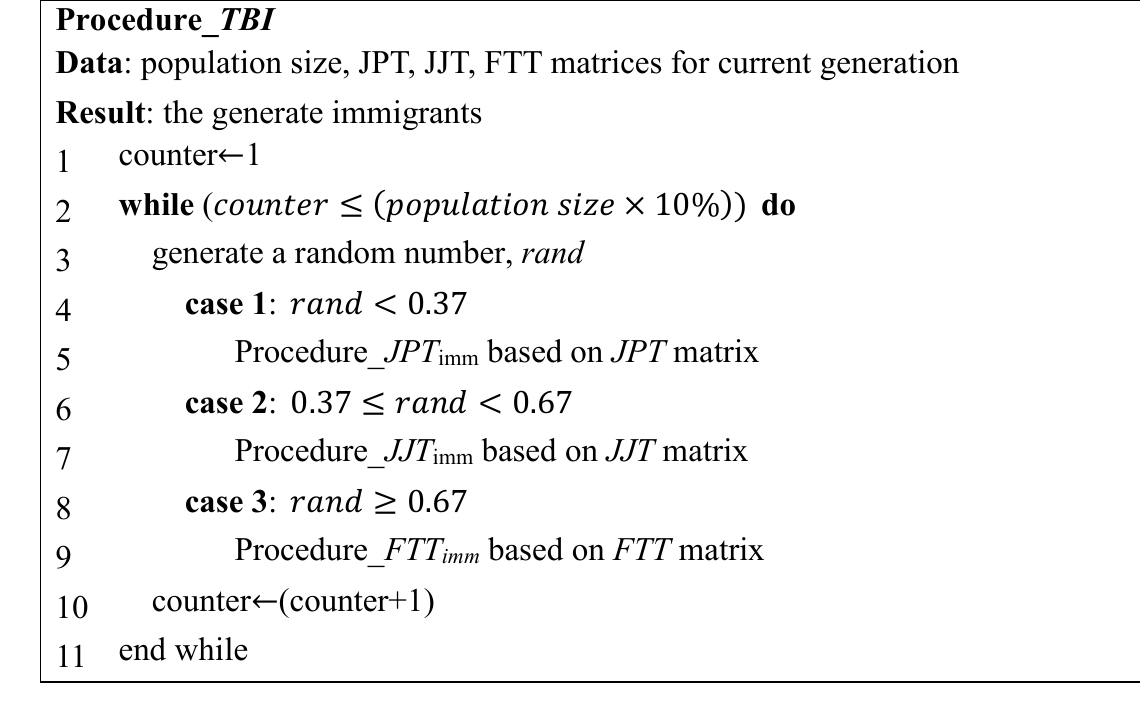
Figure 5. Pseudo code of Procedure_ TBI .